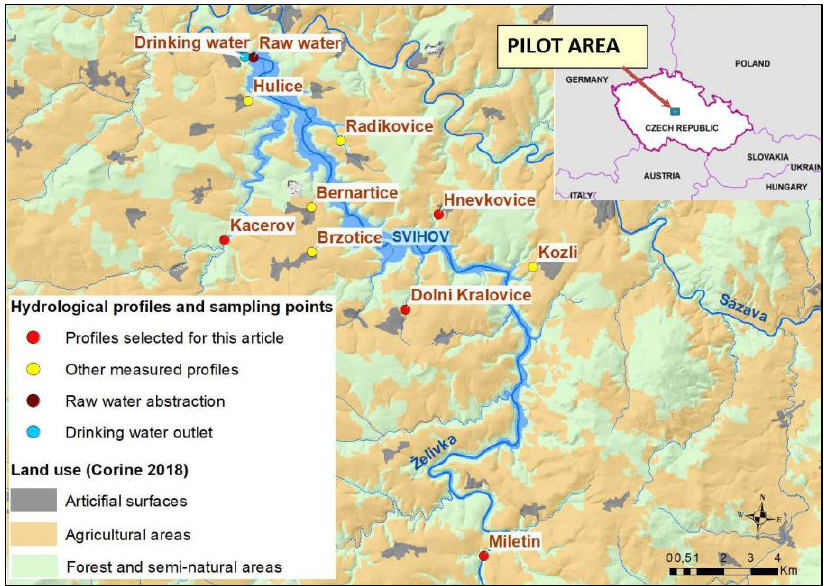
Figure 1. Svihov reservoir, location of hydrological profiles and sampling points. Topographical base map: geoportal.cuzk.cz.